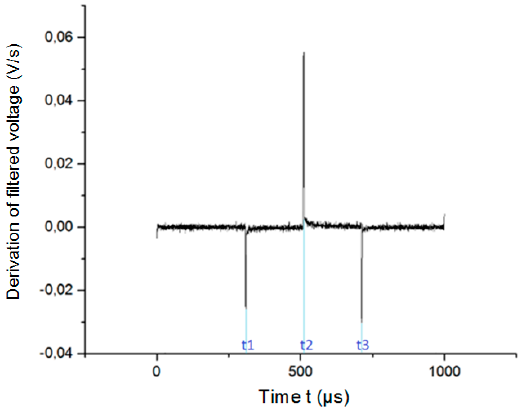
Figure 5. Time derivation of Pt electrode potential transients for 200 µs stimulation signal.